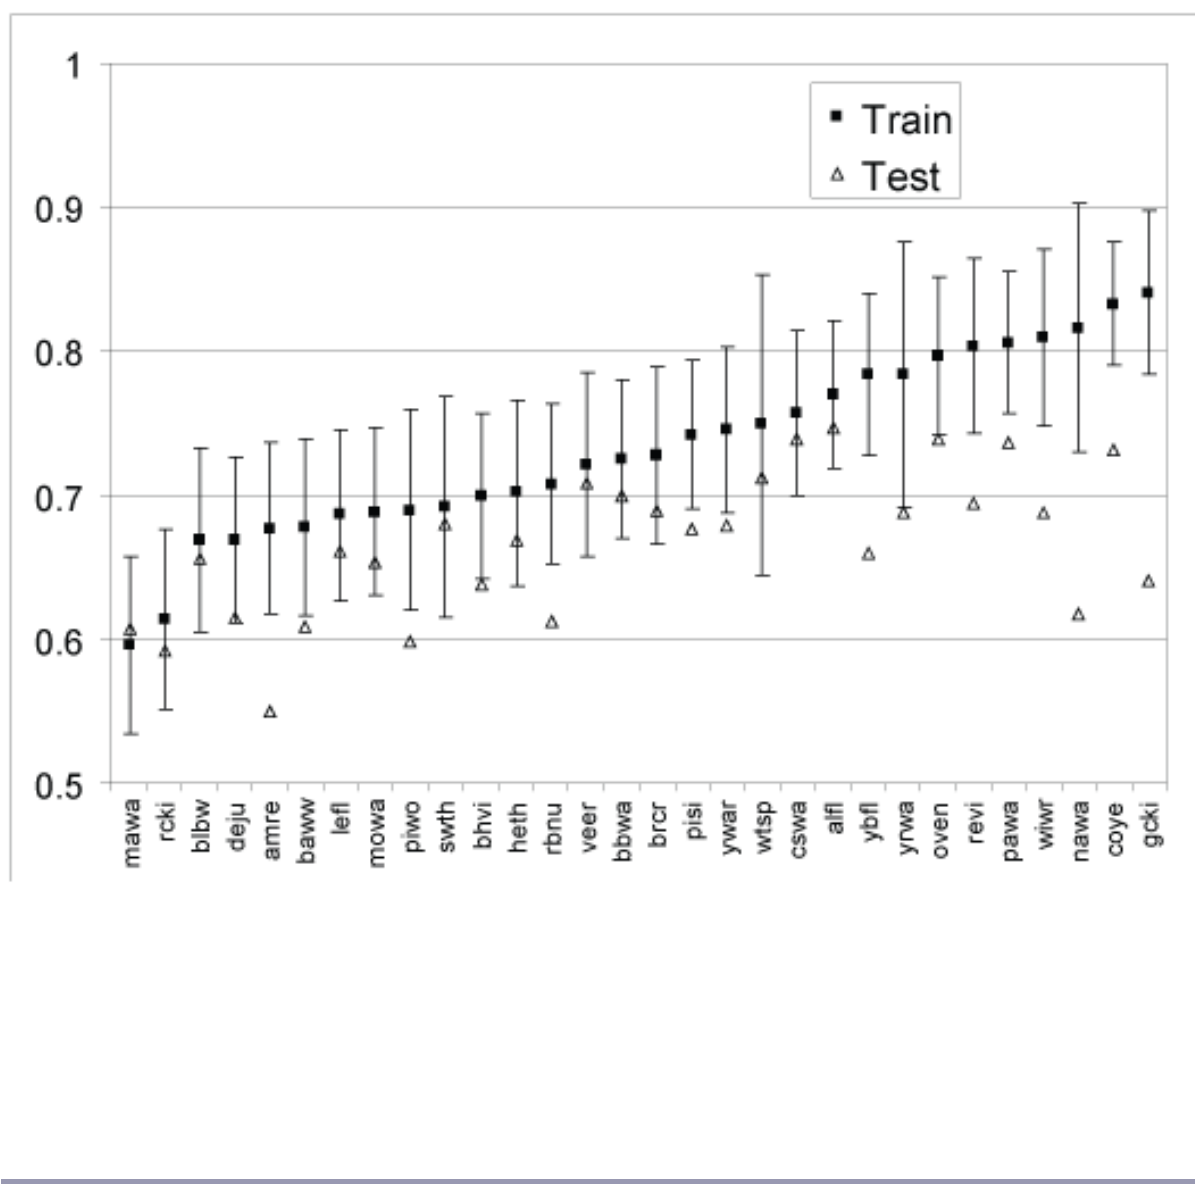
Fig. 8. Accuracy assessment (ROC) and 95% confidence limits for the habitat models. Values are area under the ROC curve, and represent the probability of correctly assigning the correct label (occupied/ unoccupied) for new observations. Closed symbols are for model development (training), and open symbols for independent test of the